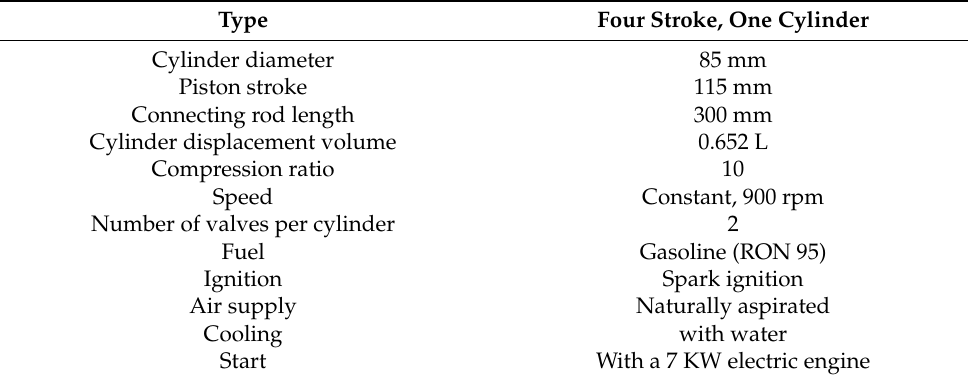
Table 1. Experimental engine characteristics.